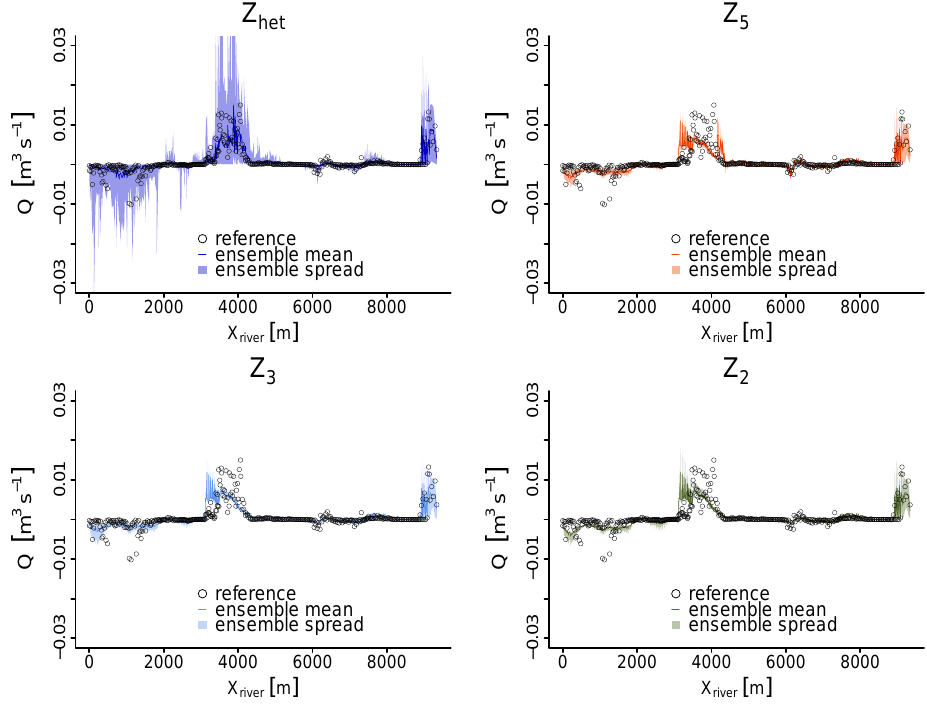
Fig. 9. Fluxes between river and aquifer along the river reach for conditional simulations with EnKF at simulation day 300 (scenario A, reference IV). Fluxes from river to aquifer have a positive sign. Distance X river is calculated starting from the two most western river nodes.